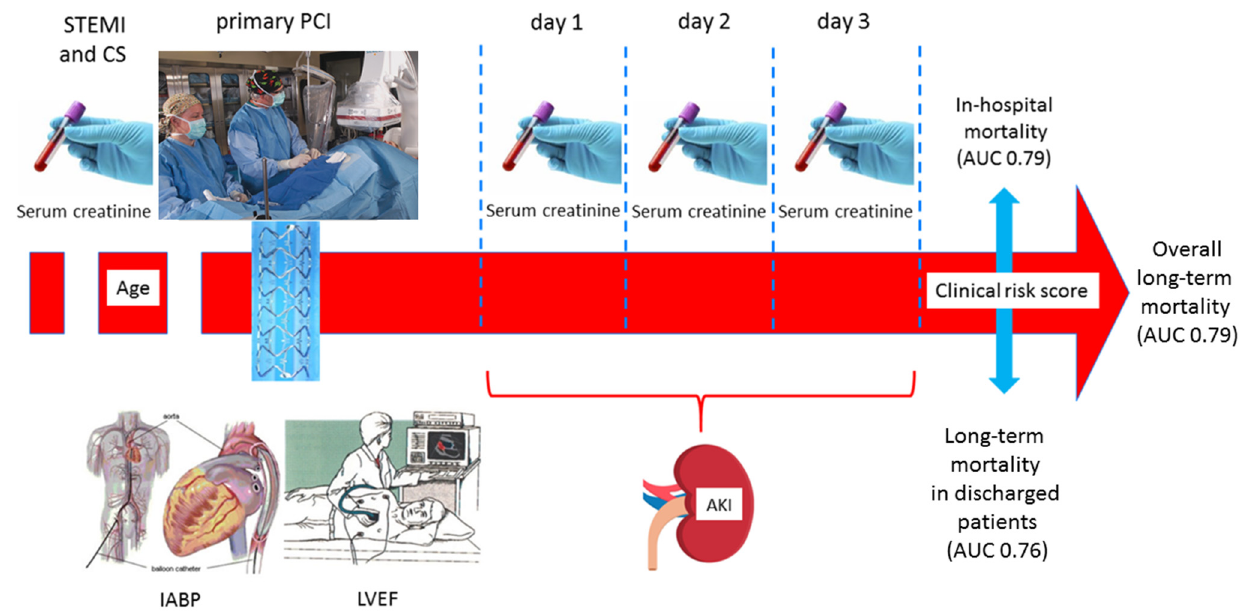
Figure 6. Schematic representation of the clinical score calculation in ST-segment elevation acute myocardial infarction (STEMI) patients with cardiogenic shock (CS) for in-hospital and long-term mortality prediction. AKI = acute kidney injury; AUC = area under the curve; IABP = intra-aortic balloon pump; LVEF = left ventricular ejection fraction; PCI = percutaneous coronary intervention.